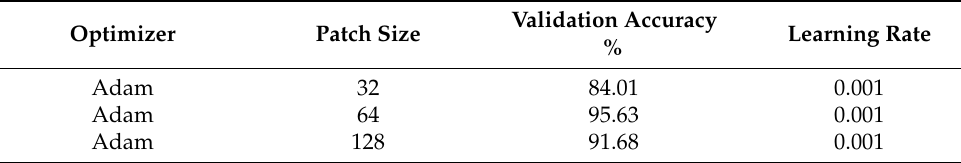
Table 2. CNN’s performance comparison for different patch sizes.